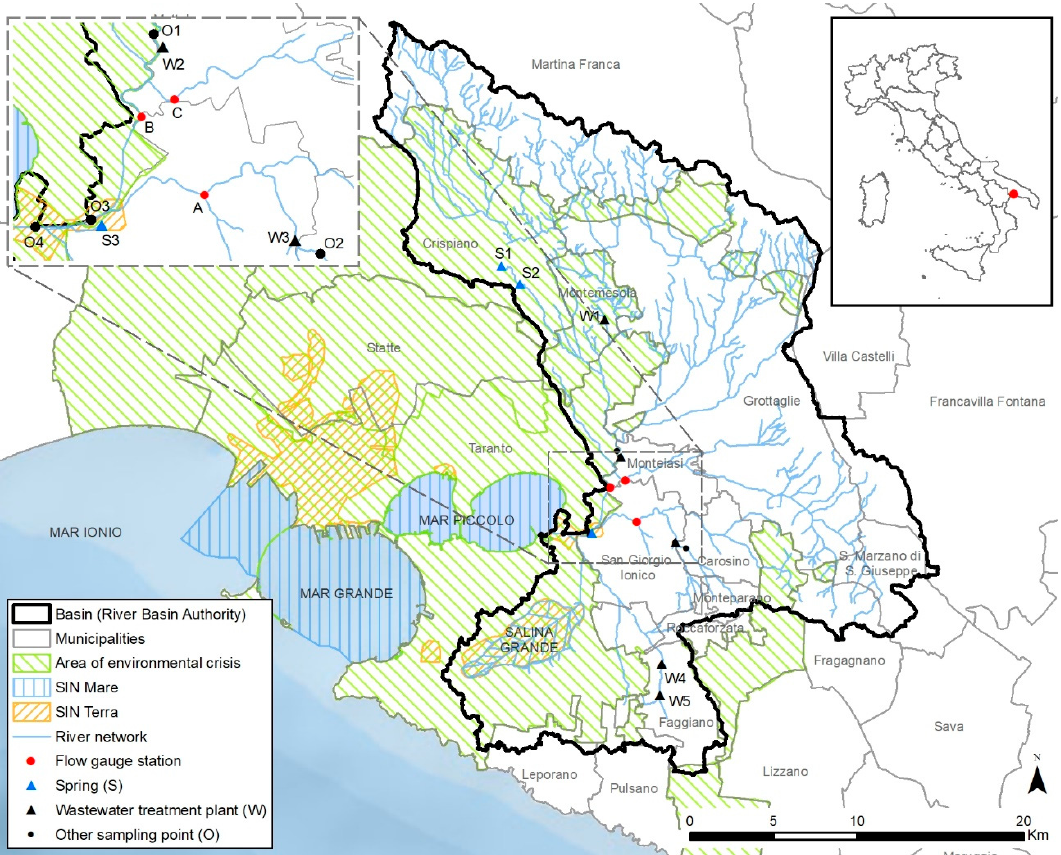
Figure 1. Study area: Canale d’Aiedda basin boundaries and location of point sources (i.e., spring and wastewater treatment plants), flow gauge stations, and sampling points. The extents of the Land and Sea contaminated Sites of National Interest (i.e., SIN Terra and SIN Mare) and of the Area of environmental crisis are also shown.